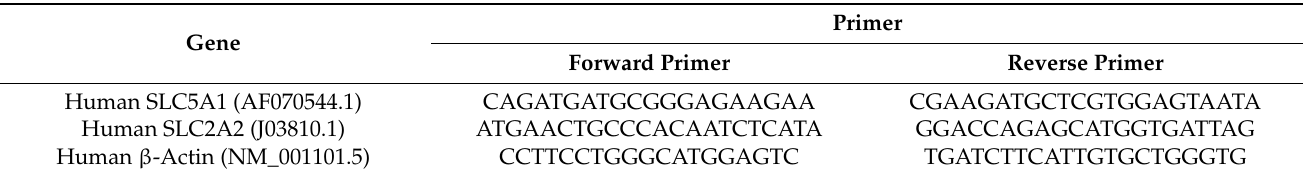
Table 2. qPCR reaction primers (5 (cid:48) –3 (cid:48)